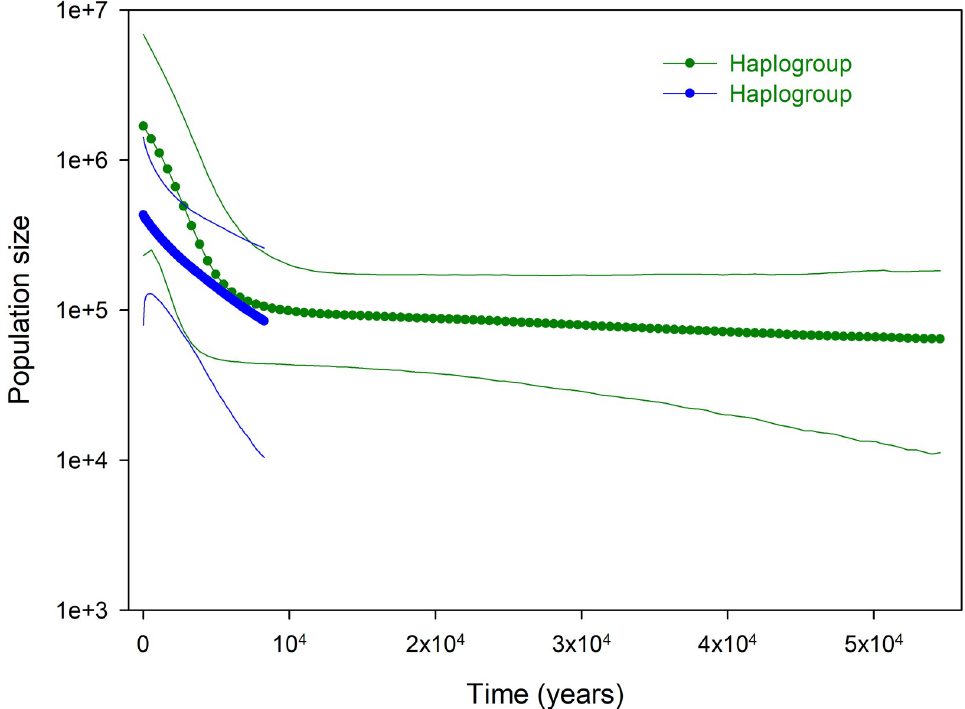
Fig 6. Bayesian skyline plot based on mitochondrial control region coalescent analysis for Octopus vulgaris haplogroups in the northeastern Atlantic.